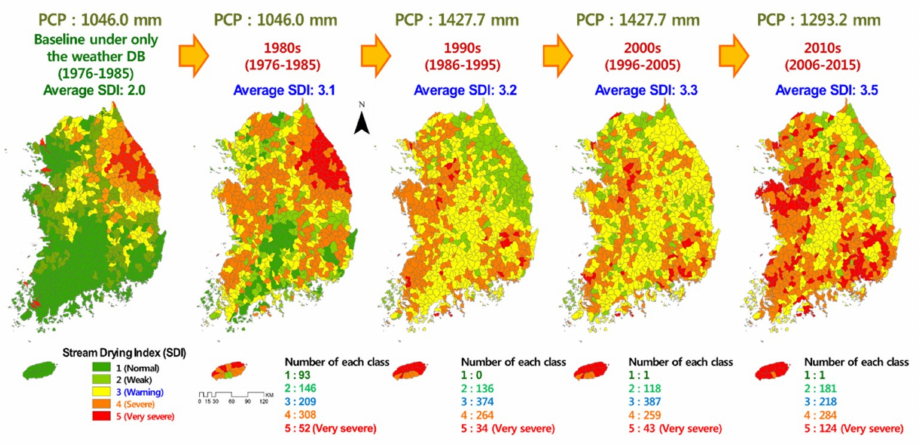
Figure 5. Distribution results of the stream drying index (SDI) and precipitation (PCP) for the periods after applying all water loss DBs (All